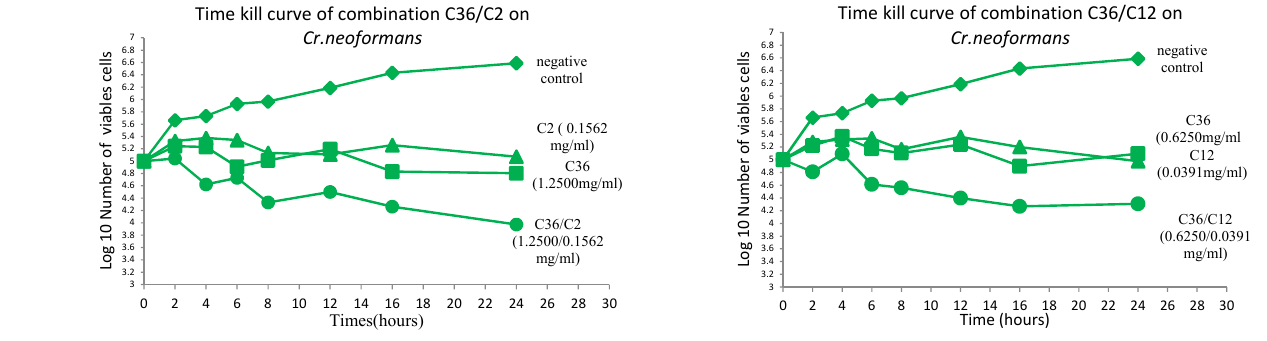
Figure 1. Time kill kinetic curves of combinations C36/C2 and C36/C12 against the tested yeasts. Sub-fractions were assessed alone and in combination for bioactivity at different time